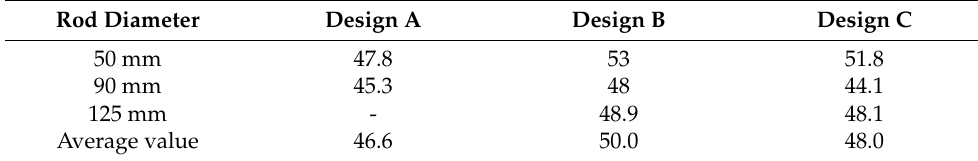
Figure 7. Boundary layer thickness along the rods. ( a ) Design A; ( b ) design B; ( c ) design C. Table 4. Boundary layer thickness deviation